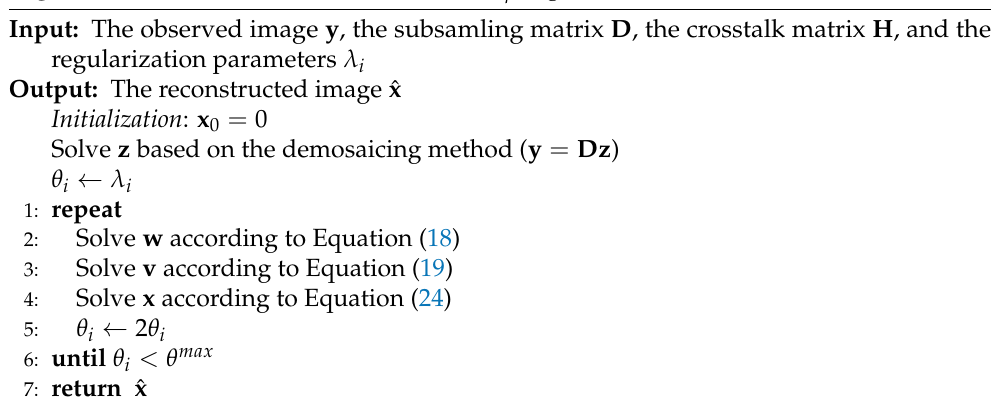
Algorithm 1 Crosstalk Correction based on L p -regularized Multi-channel